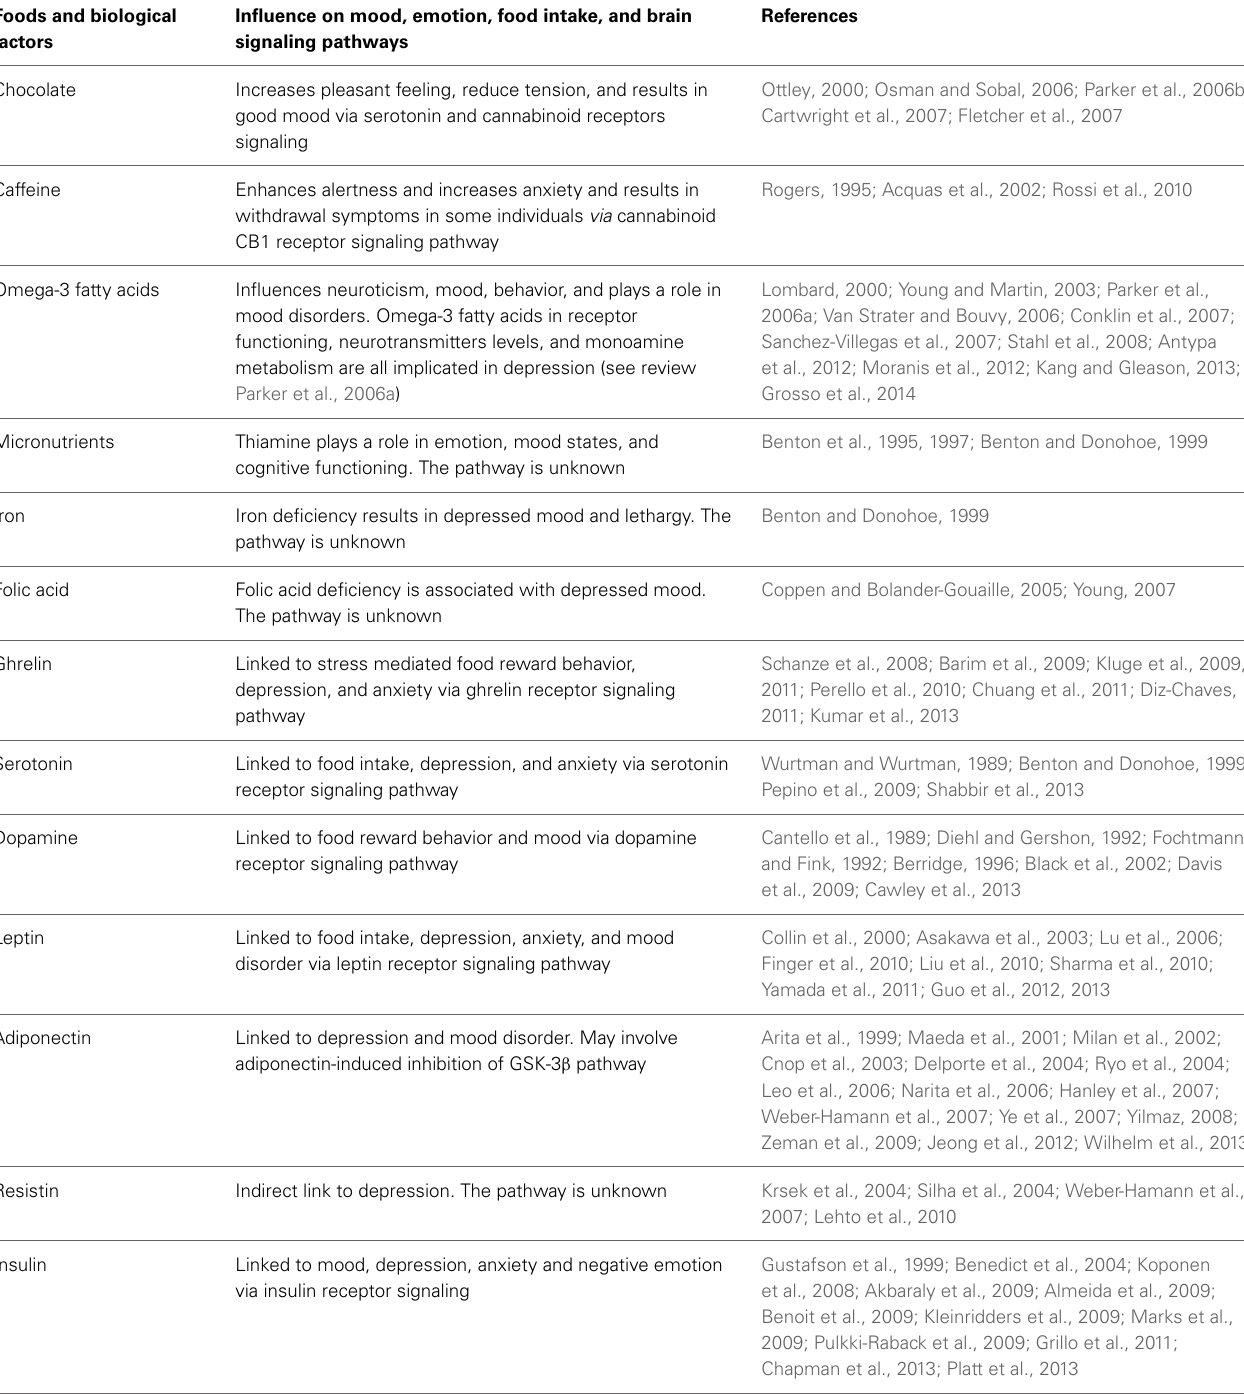
Table 1 | Summary of biological factors and food influencing mood, emotions, food intake, and brain signaling pathways. Foods and